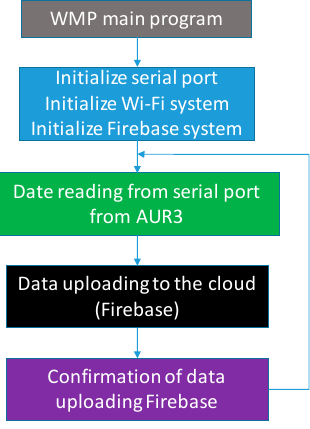
Figure 12. LLMD main program.